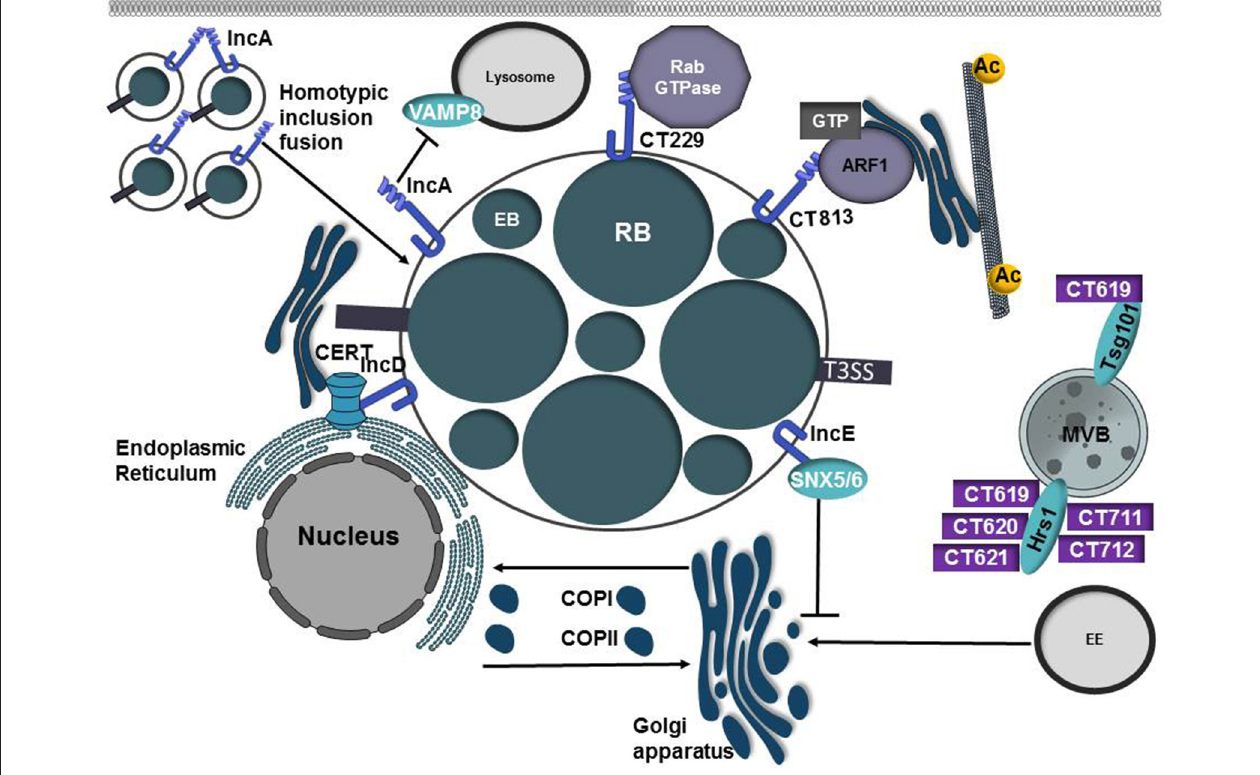
FIGURE 6 | Inclusion membrane proteins and secreted effectors from C. trachomatis co-opt host vesicular trafficking pathways to promote inclusion development. Chlamydia trachomatis replicates in a parasitophorous vacuole, termed the inclusion. Early in the infection cycle the inclusion is modified through the incorporation of type III secreted effector proteins known as inclusion membrane proteins (Incs). IncA possesses 2 coiled-coil domains that are homologous to eukaryotic SNARE motifs and these domains are required to mediate homotypic fusion of inclusions. IncA is also able to interact with VAMP8 on lysosomes and may prevent inclusion fusion with lysosomes. C. trachomatis manipulates and recruits Rab and Arf GTPases to the inclusion membrane through interactions with the inclusion membrane proteins CT229 and CT813, respectively. While the mechanism of CT229-Rab interactions is ill-defined, CT813 is presumed to modulate Arf GTPases to control Golgi ministack positioning by regulating microtubule posttranslational modification. IncE interacts with SNX5/6, components of the retromer complex, to disrupt trafficking to the trans- Golgi network and to promote chlamydial infection. To acquire the sphingomyelin precursor ceramide, IncD interacts with the Pleckstrin homology (PH) domain of CERT allowing ceramide to be directly transferred from the ER to the inclusion membrane. C. trachomatis also secretes a large repertoire of type III proteins into the eukaryotic cells. CT619, CT620, CT621, CT711, CT712 are type III substrates that interact with Hrs and/or Tsg101, components of the ESCRT